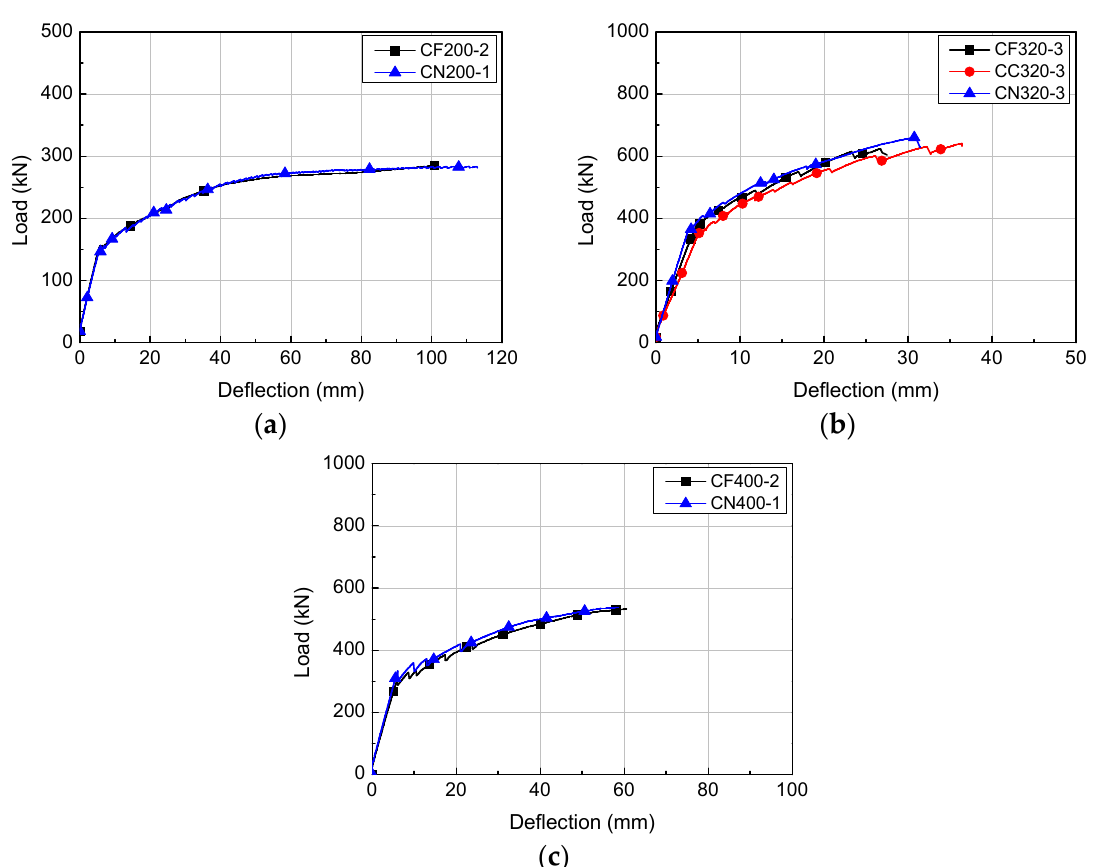
Figure 9. Comparison of load-deflection relationships according to the surface roughness directions: ( a ) H200 series; ( b ) H320 series; ( c ) H400 series.